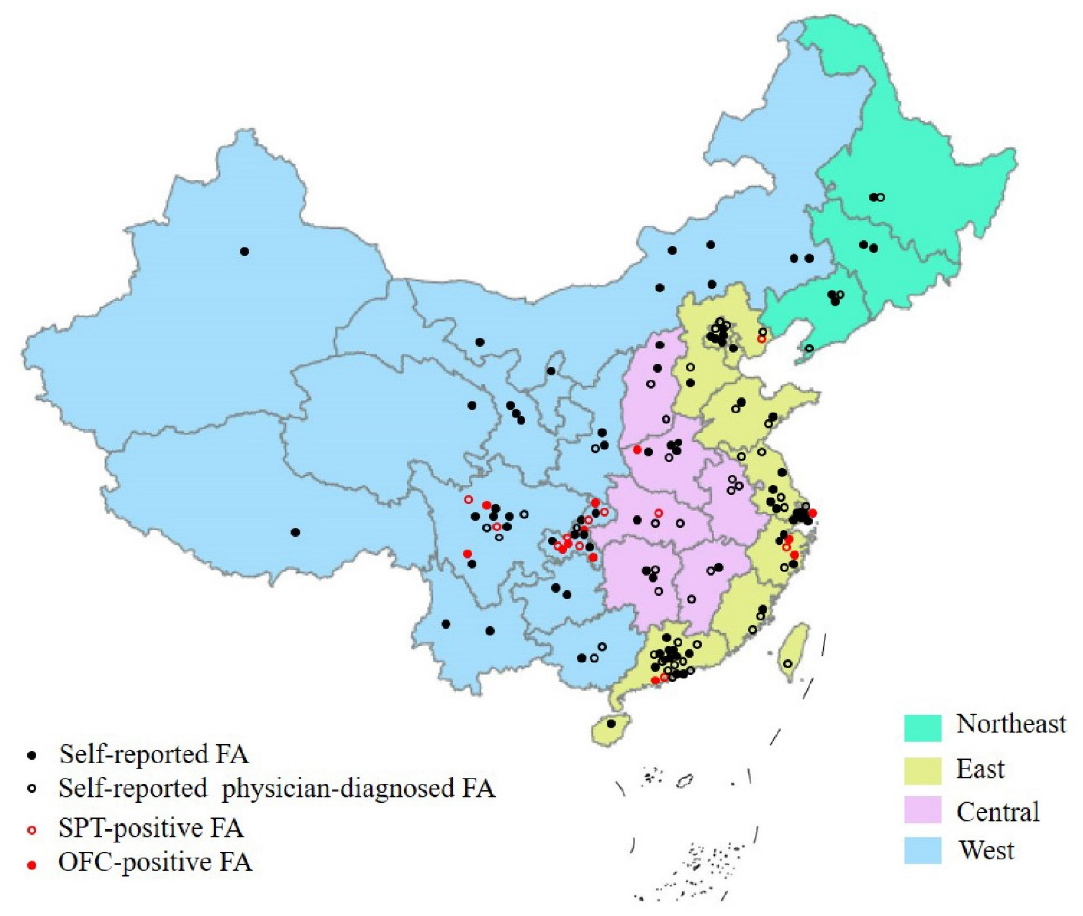
Figure 3. The geographic distribution of included studies on prevalence of FA in China. FA, food allergy; OFC, open food challenge; SPT, skin prick test.